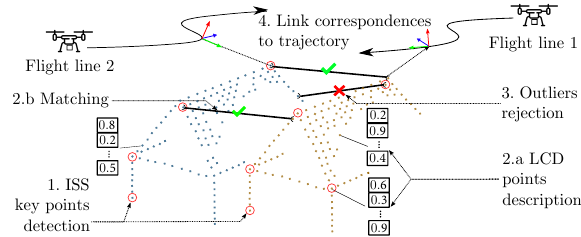
Figure 1. Steps of 3D tie-point extraction: (1) feature detection, (2a) description, (2b) matching and (3) filtering for point-cloud to point-cloud registration, after (Brun et al., 2022)